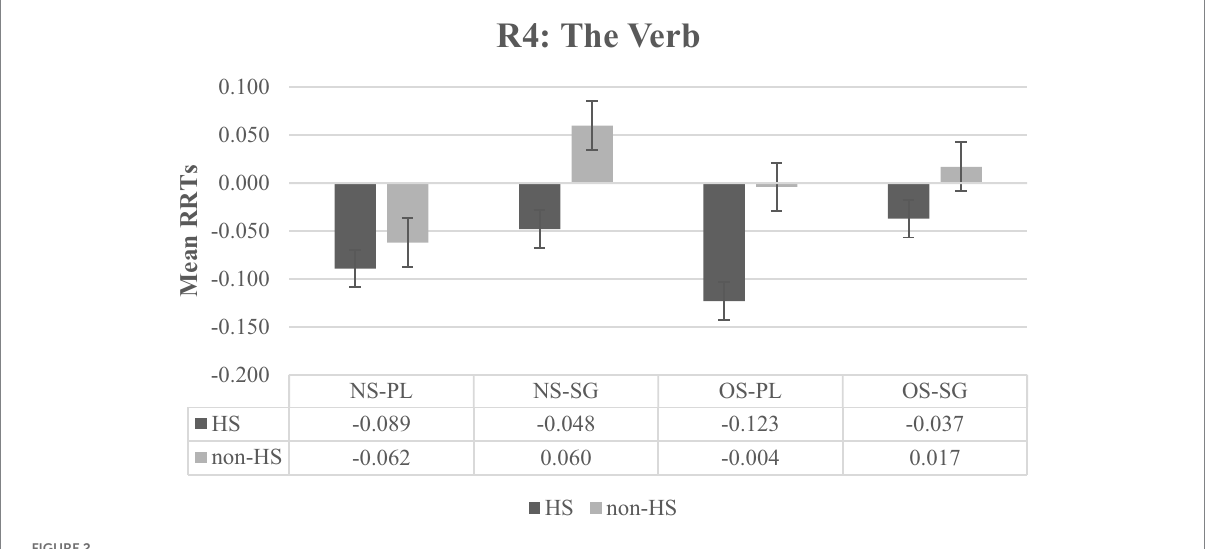
FIGURE 2 Mean RRTs of both groups for Region 4 (The verb). RRTs, Residual reading times; HS, Heritage speakers; non-HS, Non-heritage speakers; NS, Null subject; OS, Overt subject; PL, Verb is plural-marked; SG, Verb is unmarked.